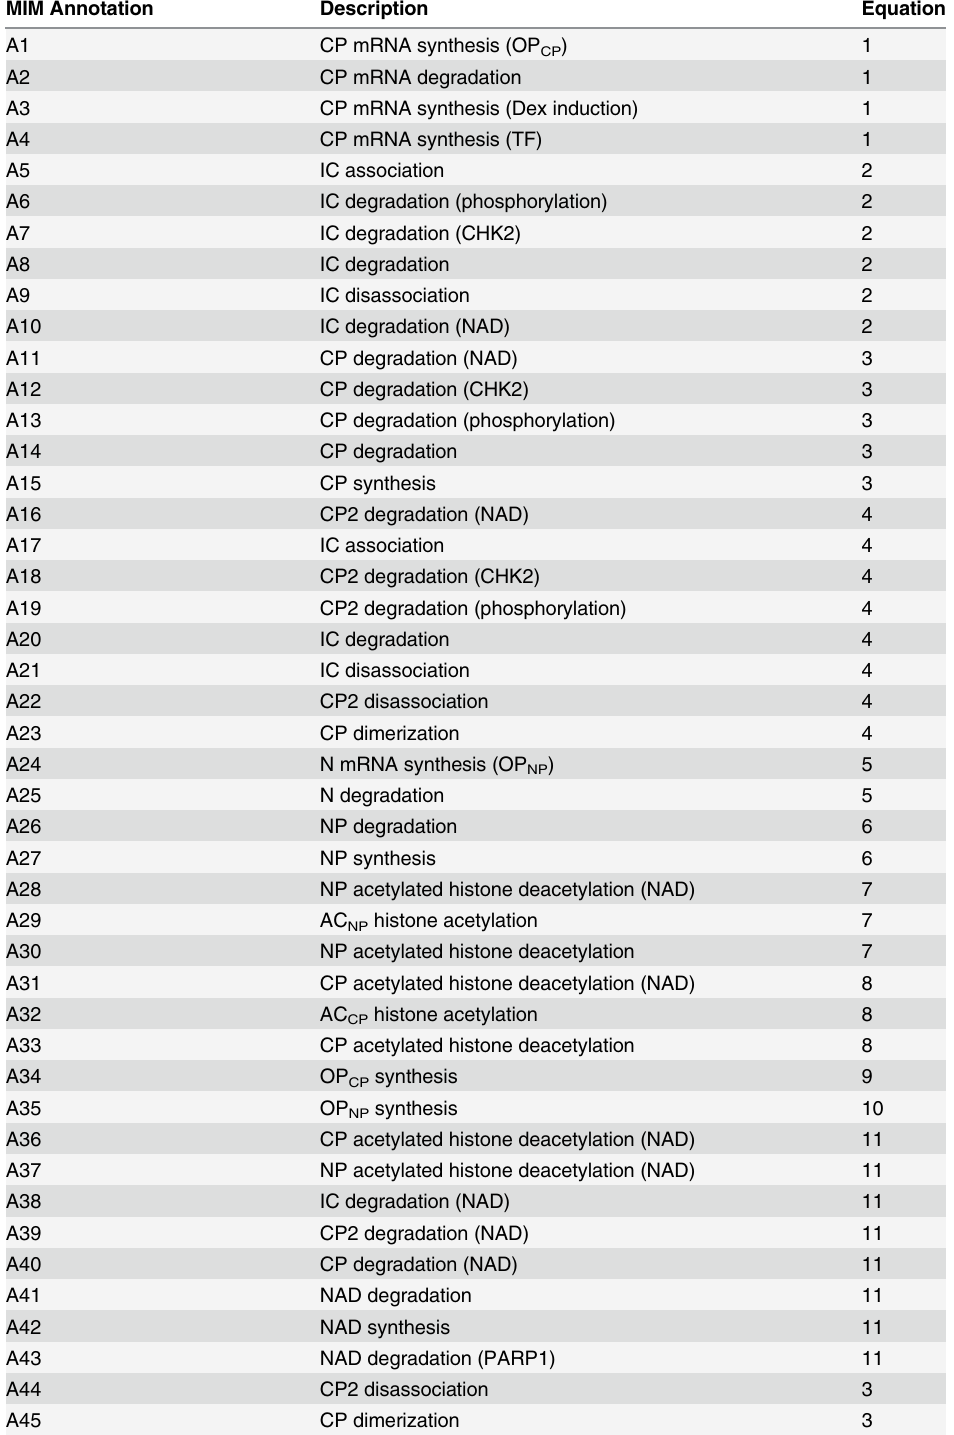
Table 1. Description of MIM wiring diagram and connection to model